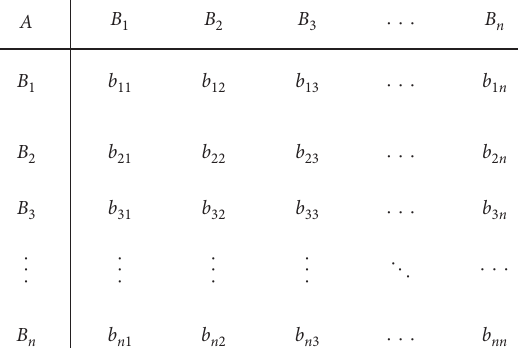
Figure 9: Diagram of the judgment